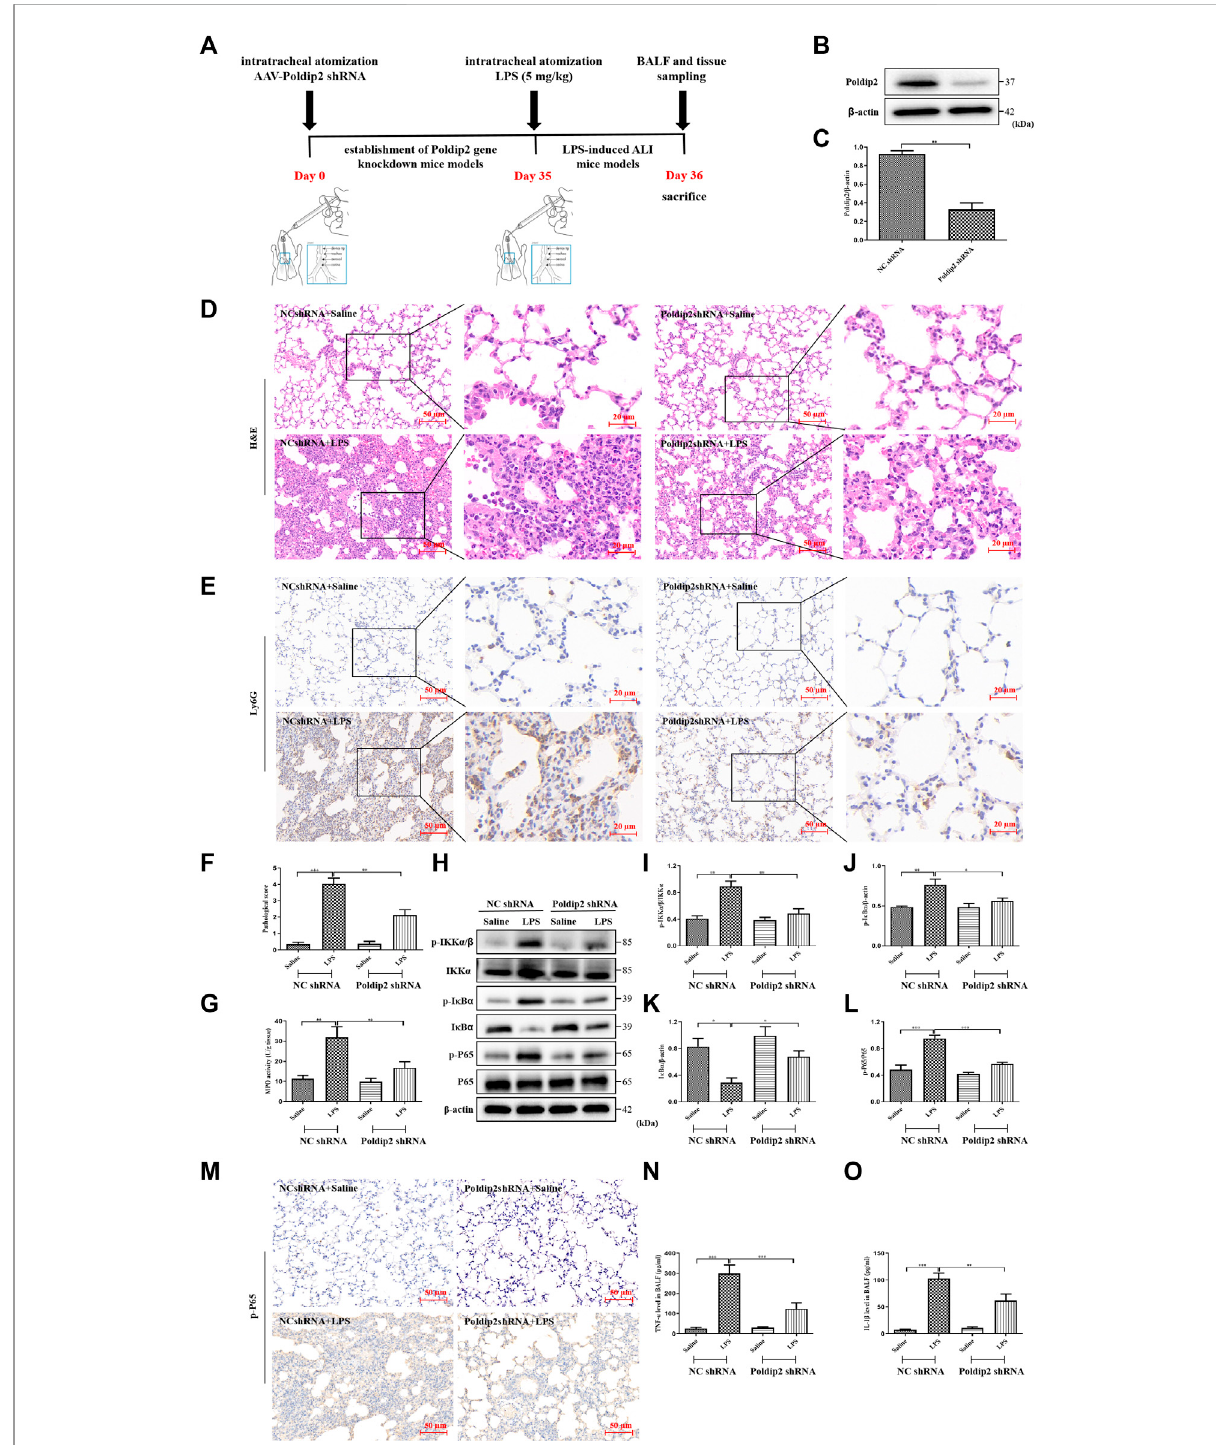
FIGURE 1 Poldip2 knockdown alleviates in fl ammation in LPS-induced mice ALI. (A) Diagram shows the experimental design. (B,C) The protein level of Poldip2 was detected by western blot (B) and quantitatively analyzed (C) . Male C57BL/6 mice were intratracheally atomized with AAV6 vector expressing Poldip2 shRNA or NC shRNA. Thirty- fi ve days later, 5 mg/kg of LPS or saline was given via intratracheal atomization for 24 h (D) Representative imagesshowing H&E staining inlung tissue sections, the original image is×200, themagni fi ed images showed cropped images outlinedcorrespondingly. (E) RepresentativeimagesshowingimmunohistologicalstaningofLy6Ginlungtissuesections,theoriginalimageis×200,